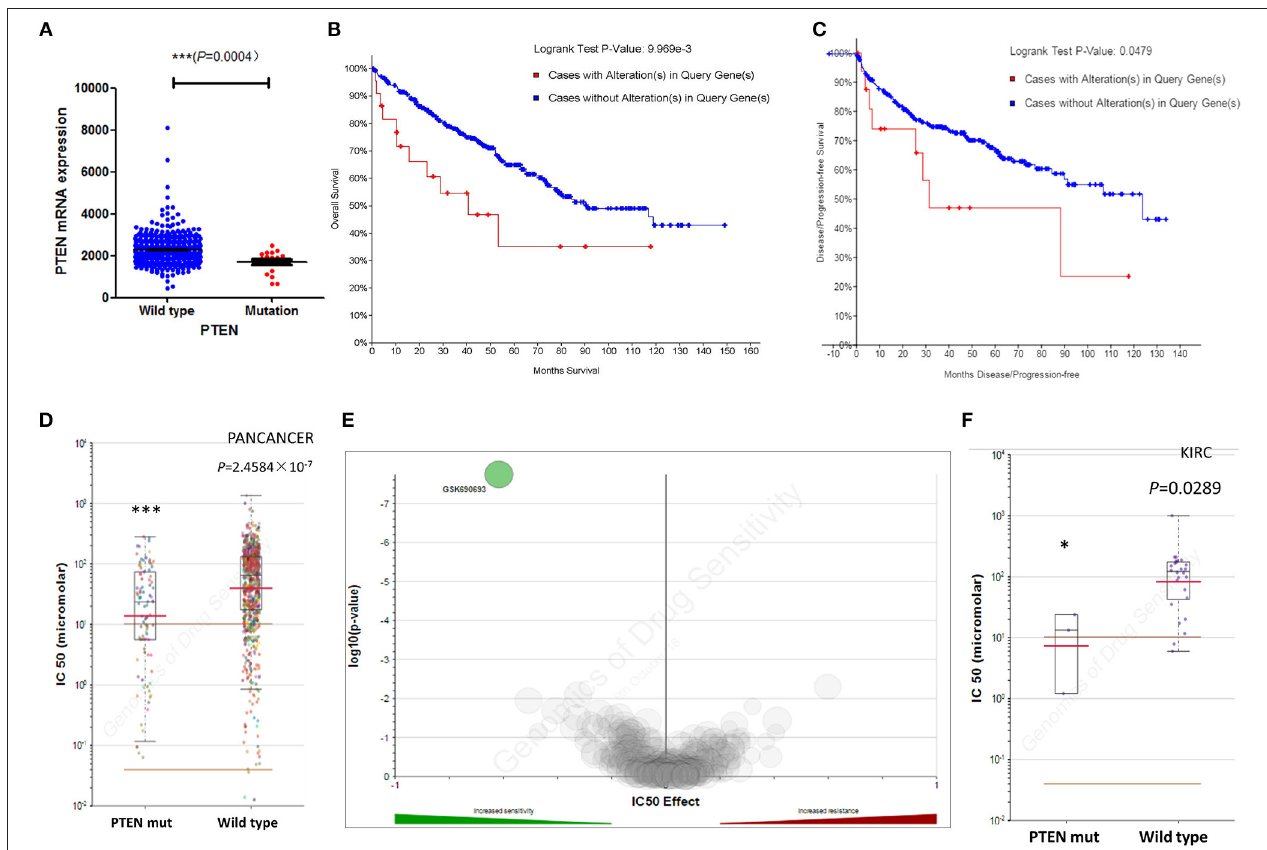
FIGURE 2 | Mutations of PTEN are not associated with ccRCC prognosis and drug selection. (A) Correlation between the PTEN mutation and mRNA expression. (B,C) Kaplan–Meier survival and disease recurrence curves for renal clear cell carcinoma patients stratified by the PTEN mutation. (D,E) Scattered plot and volcano plot show that multiple cancer cell types with the PTEN mutation were significantly inhibited by GSK690693. (F) Reproduction of the GDSC database by excluding cancer of other types showed that RCC cells with the PTEN mutation was also significantly inhibited by GSK690693. * P < 0.05, *** P <